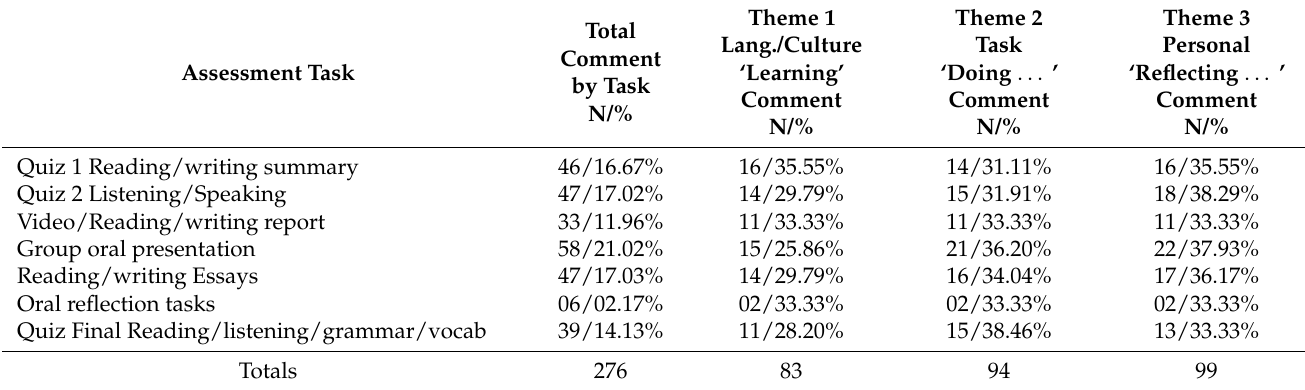
Table 4. Distribution of number and frequency of comments by task, total and